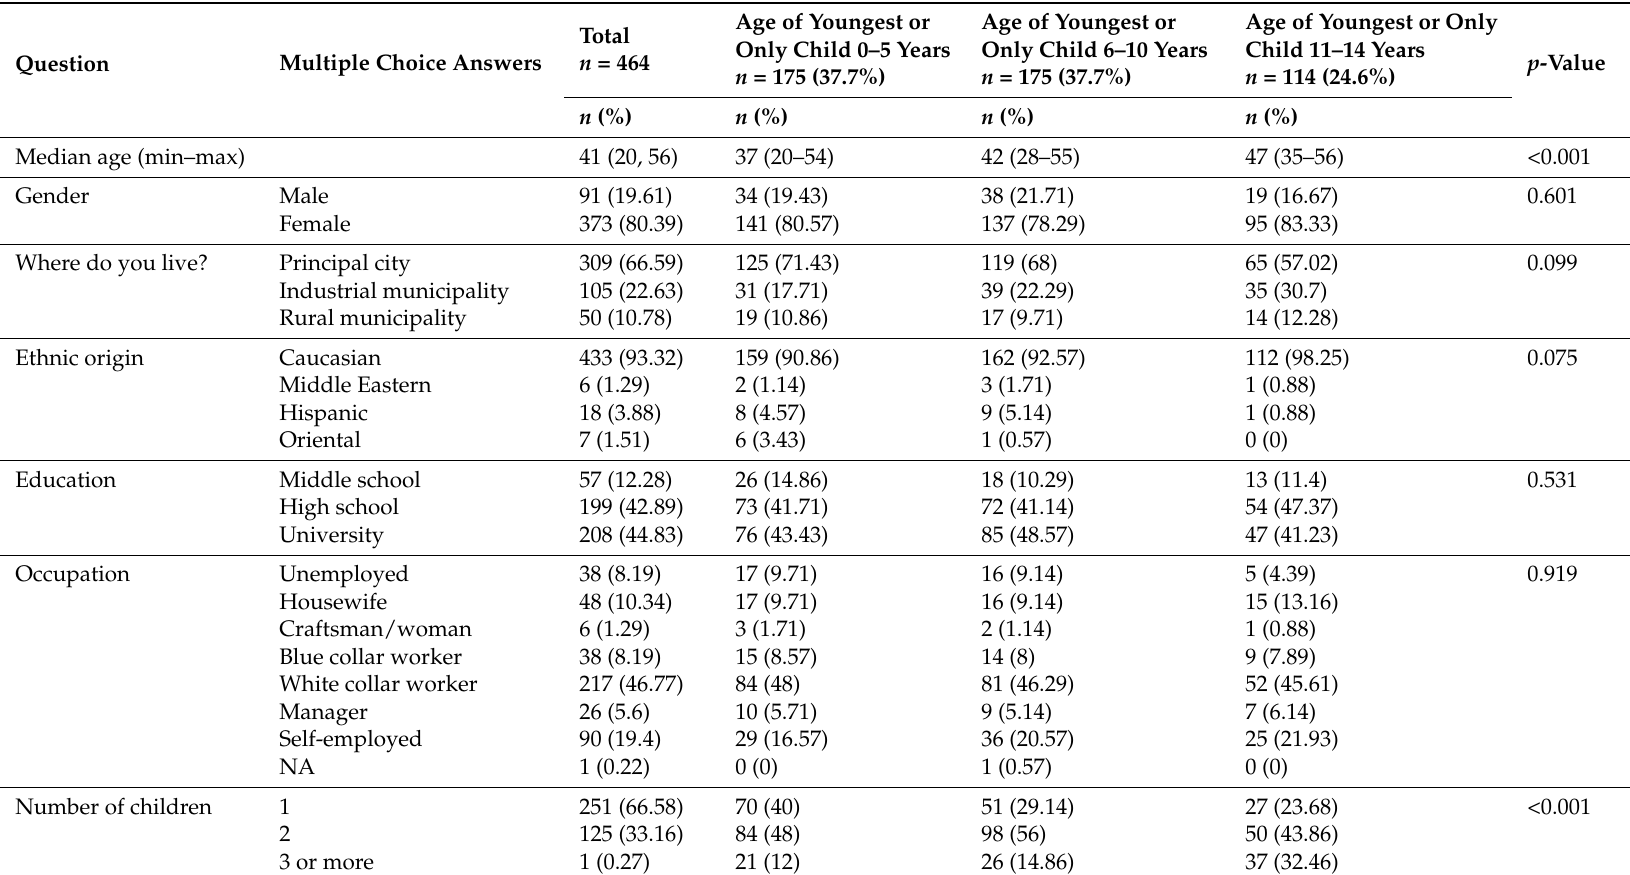
Table 4. Demographic characteristics of responding